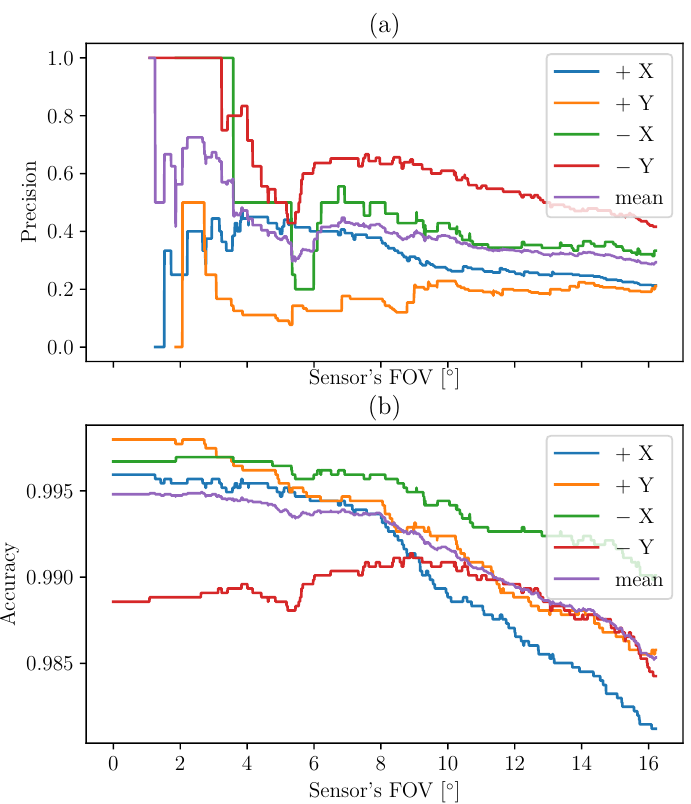
Figure 12. Precision ( a ) and accuracy ( b ) of the MEKF method based on the UVS indicator. The methods can be compared by computing the difference between the indicators for MEKF and TRIAD. The results are presented in Figure 13. The MEKF method allows us to increase the precision by about 20% and the accuracy by a few